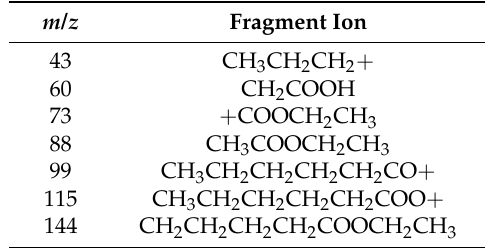
Table 2. Molecular ion fragments of ethyl hexanoate mixtures. The mass spectrum showed the presence of ethyl hexanoate (144 m / z ) in the sample with the compound structure and fragment molecular